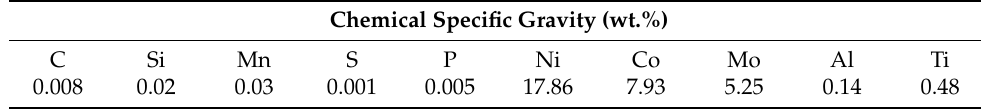
Table 2. Chemical composition of maraging steel 18Ni (250).